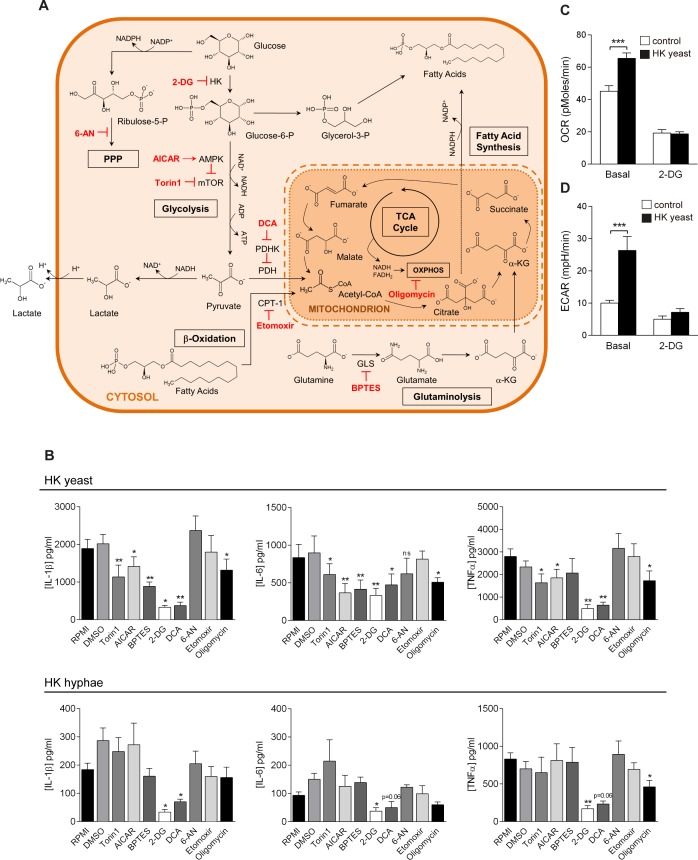
Glycolysis, glutaminolysis and oxidative phosphorylation are involved in cytokine production after Candida stimulation.(A) Scheme of the chemical inhibitors used, their target enzymes, and the main intracellular metabolic pathways studied. (B) IL-1β, IL-6 and TNFα production by human monocytes treated with different metabolic inhibitors and stimulated with heat-killed C. albicans yeast or heat-killed C. albicans hyphae for 24 h (mean ± SEM, n = 6; pooled from 2 independent experiments). *p<0.05, **p<0.01 Wilcoxon signed-rank test. (C-D) Basal OCR (C) and ECAR (D) of monocytes were determined 24 h after stimulation with medium or heat-killed C. albicans yeast by extracellular flux measurements in basal conditions of after injection of 2-DG (mean ± SEM, n = 6; pooled from 2 independent experiments). *p<0.05, **p<0.01 Wilcoxon signed-rank test.